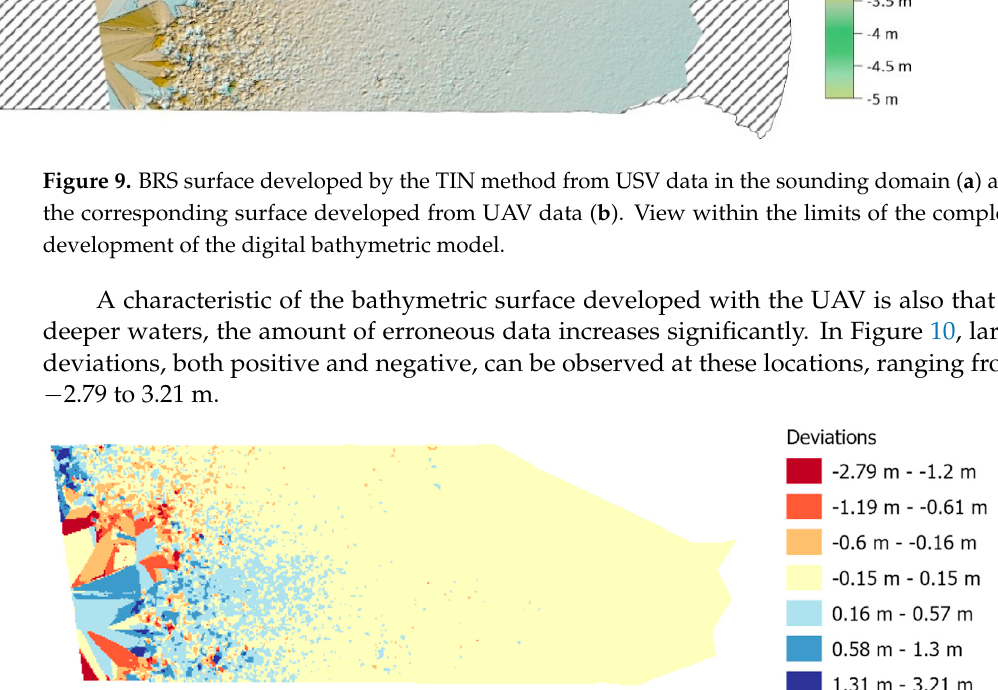
Figure 10. Deviation of depth values between photogrammetric surface and BRS.